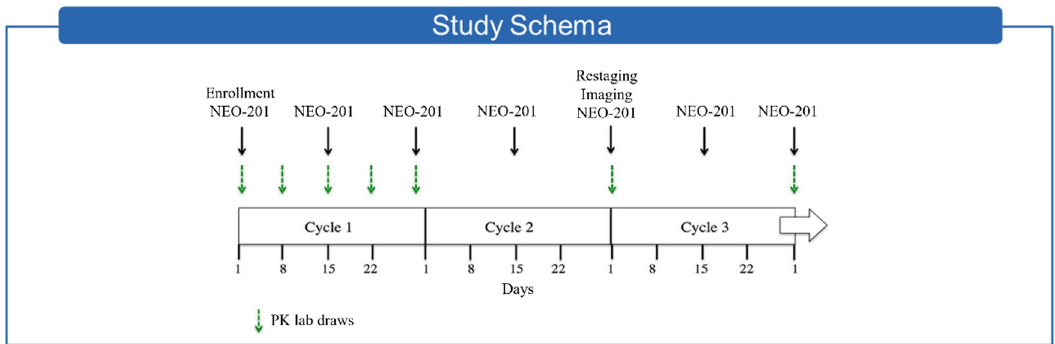
Figure 3. Study schema of the first in human clinical trial using